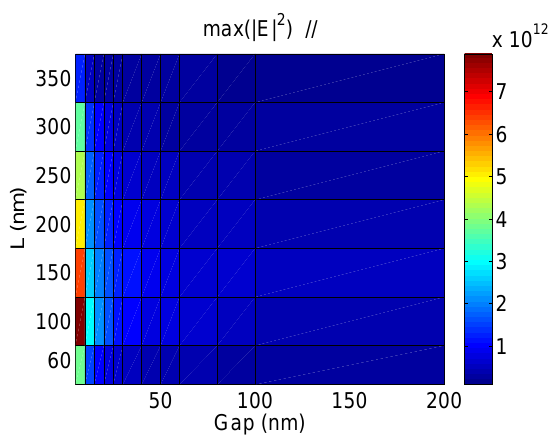
Figure 10: Maximum of intensity | E | 2 , ( V 2 /m 2 ) , as a function of the particle length L and the gap for perpen- dicular polarization